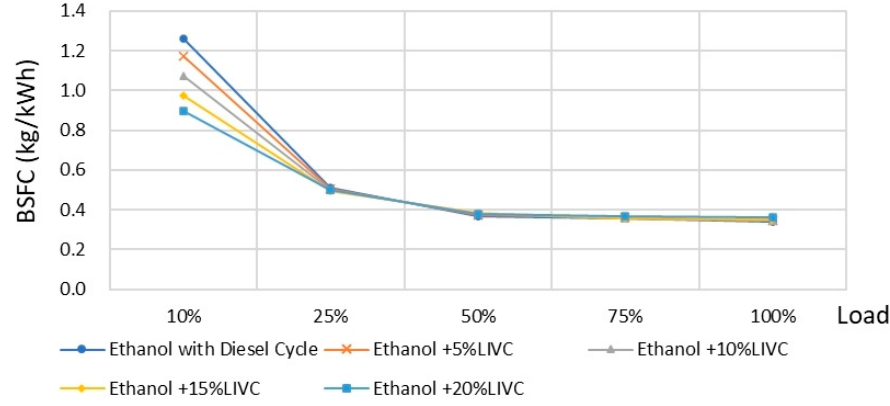
Figure 21. BTEE(%) of ethanol engine with LIVC Miller Cycle. Figure 22. NOx emission(ppm) of ethanol engine with LIVC Miller Cycle. The variability in brake power, BSFC and brake thermal efficiency for the EIVC ver- sion of the Miller cycle compared to the original diesel cycle ethanol-fueled engine at 10%, 25%, 50% and 75% load is quite small, remaining at around ±5% (except for the 10% load − 20%EIVC condition). Ethanol has a low ignition point and burns easily in reaction with